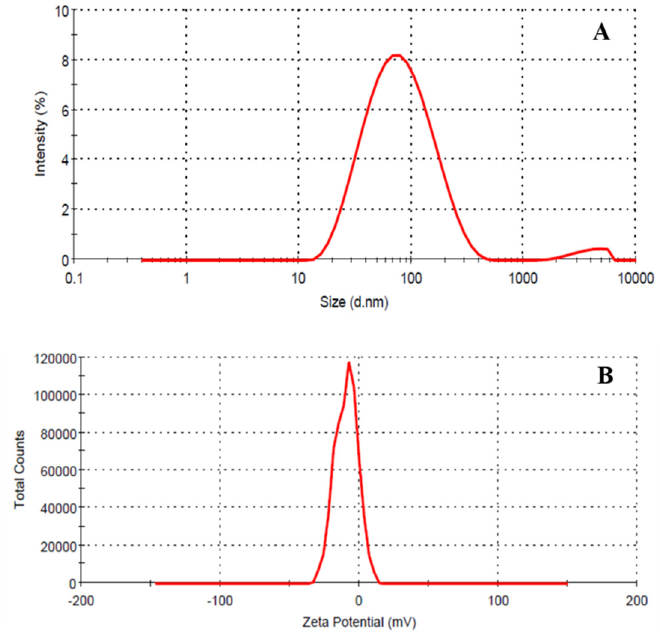
Figure 5. ( A ) DLS and ( B ) zeta potential for Nd 2 Se 3 NPs. Possible Mechanism